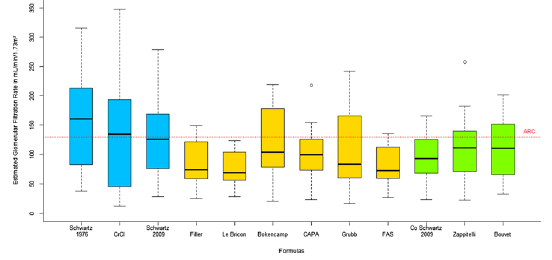
Fig. 1 Boxplots of the glomerular filtration rate estimates in mL min − 1 1.73 m − 2 according to 12 formulas. In blue, yellow and green, formulas depending respectively on creatinine, cys‑ tatin C and both. In dotted red line, the limit defining augmented